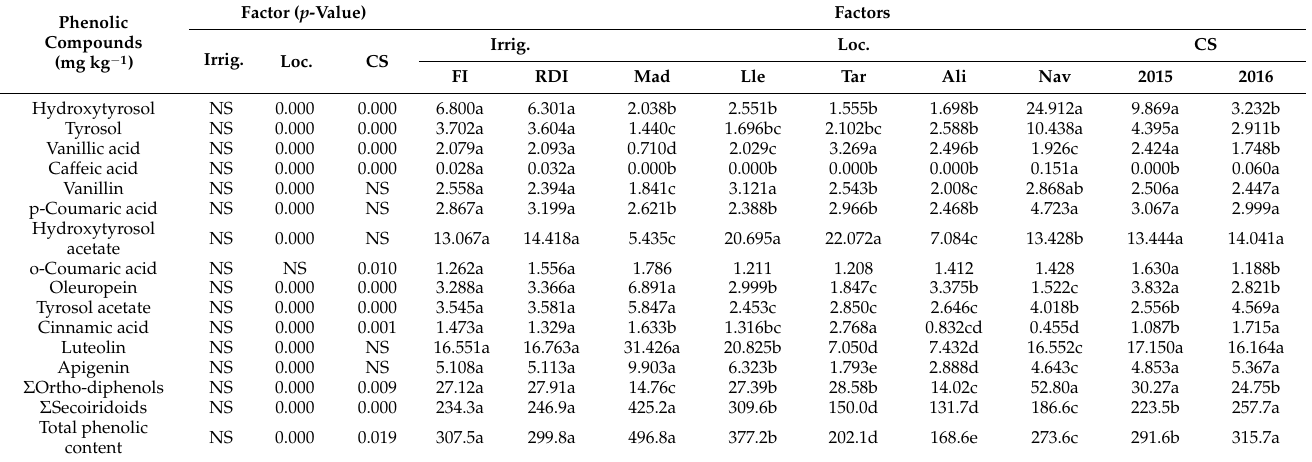
Table 3. Three-way ANOVA (prob > F) and least square means of the phenolic profiles of the different